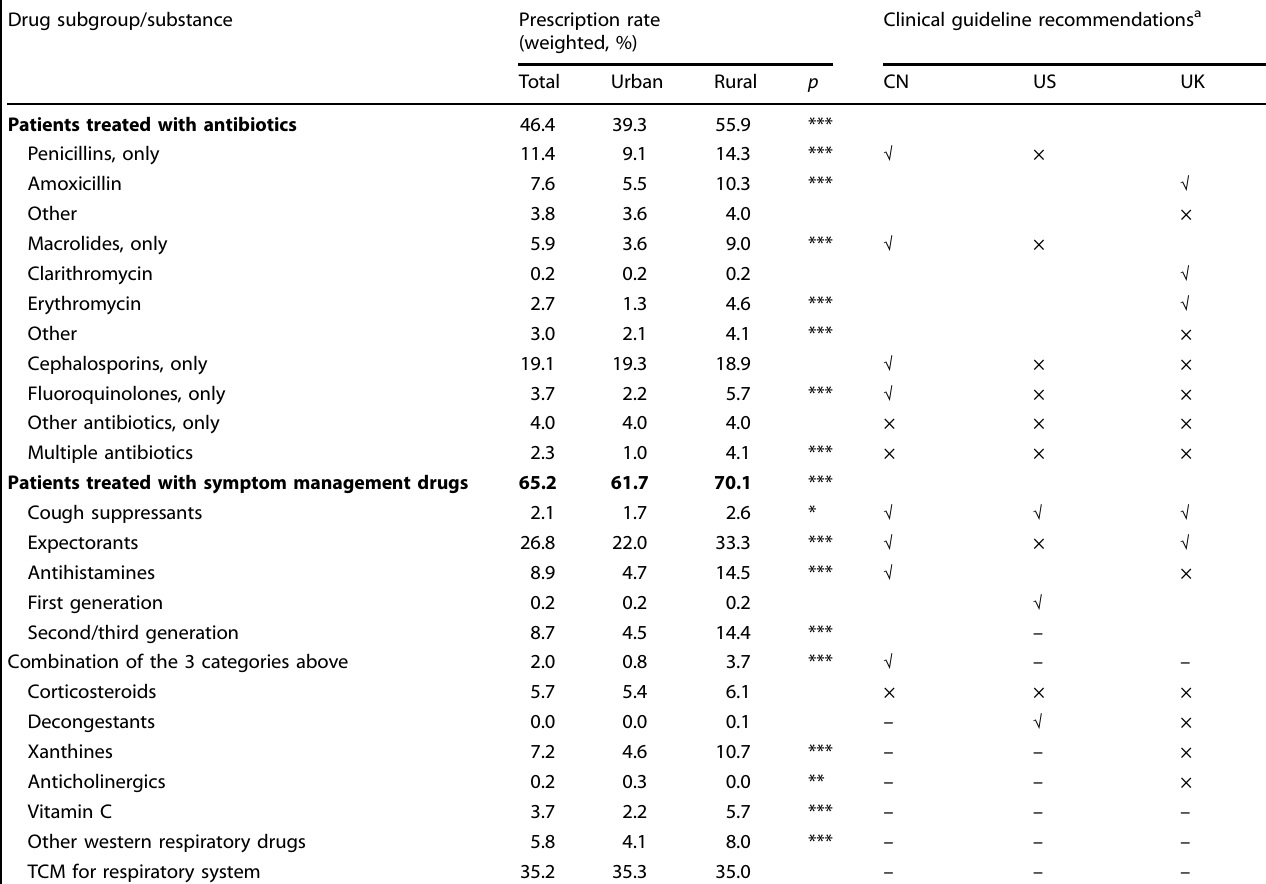
Table 3. Prescribing of antibiotic and symptom management medications for adult acute bronchitis at primary healthcare facilities in China, by urban – rural location and whether medications were included in clinical